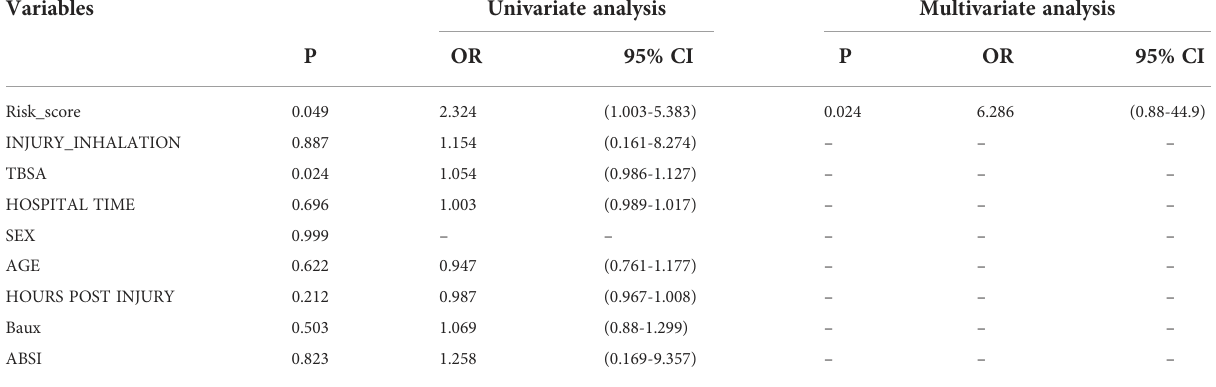
TABLE 2 Univariate and multivariate logistic regression for risk score and clinical